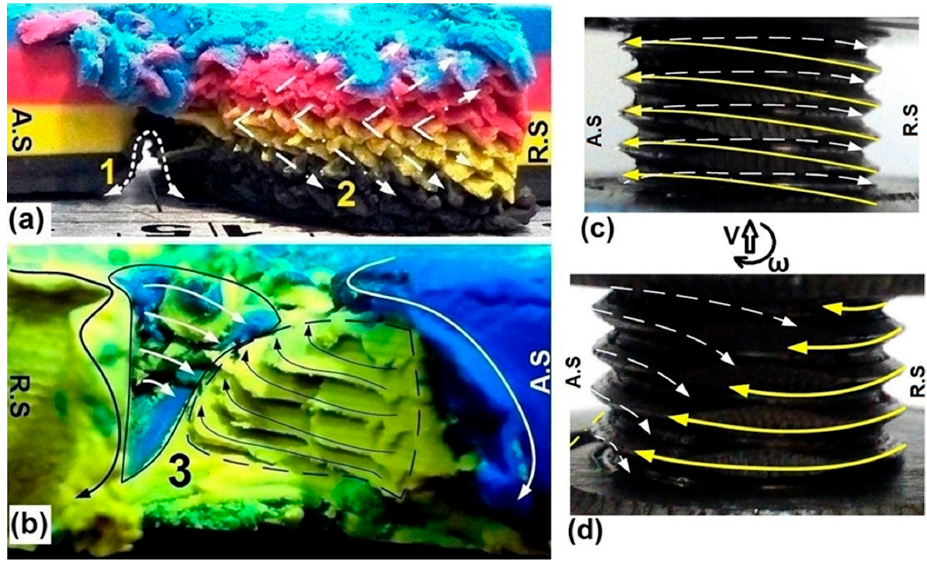
Figure 5. ( a ) Effect of threads in the entry zone; and ( b ) the exit zone, replicated in analogue model; (1) tunnel void, (2) schematic of the shear-bands in the entry zone, (3) schematic of the shear-bands in the exit zone; and ( c , d ) Schematic of the shear flow around the pin for the entry zone and exit zone, respectively.